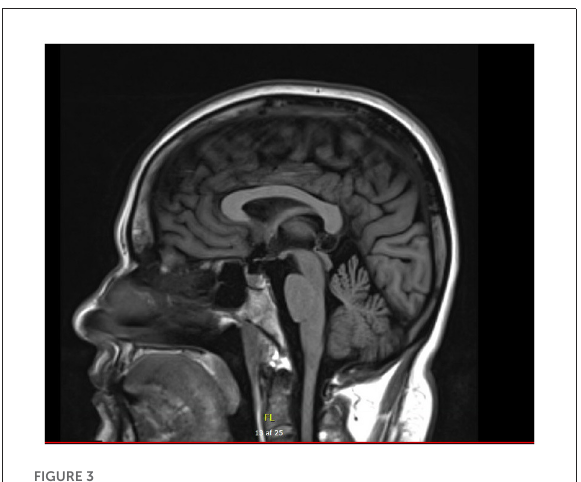
FIGURE3 Cerebral MRI of patient B with cerebellar atrophy involving